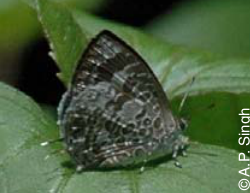
Image 37. Dark Himalayan Oakblue, Arhopala rama